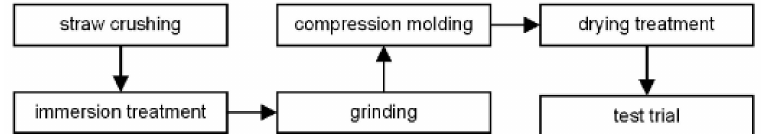
Figure 4. Flow chart of straw fiber preparation and test.